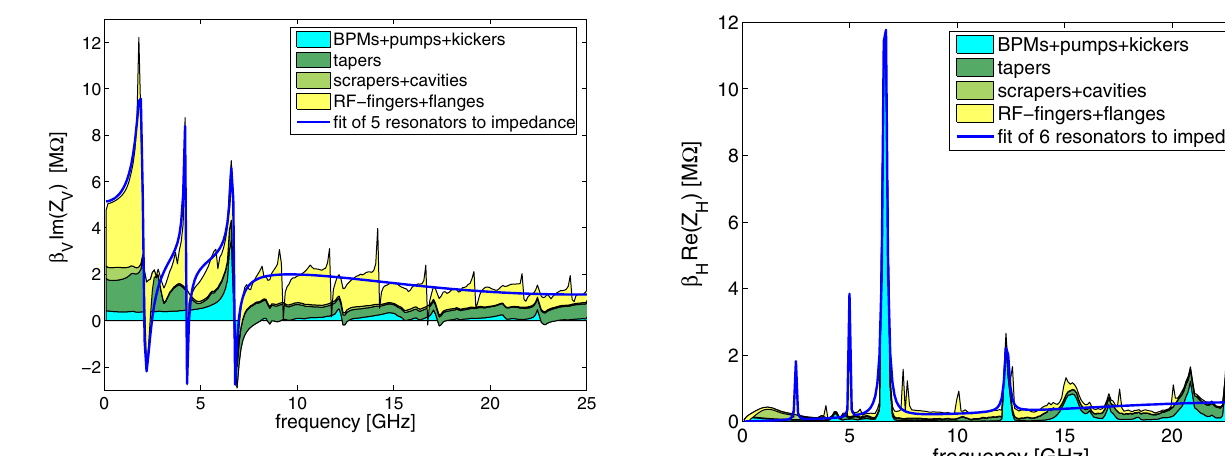
FIG. 10. (Color) Spectrum of the (cid:1) -weighted imaginary part of the vertical impedance due to geometrical variation.